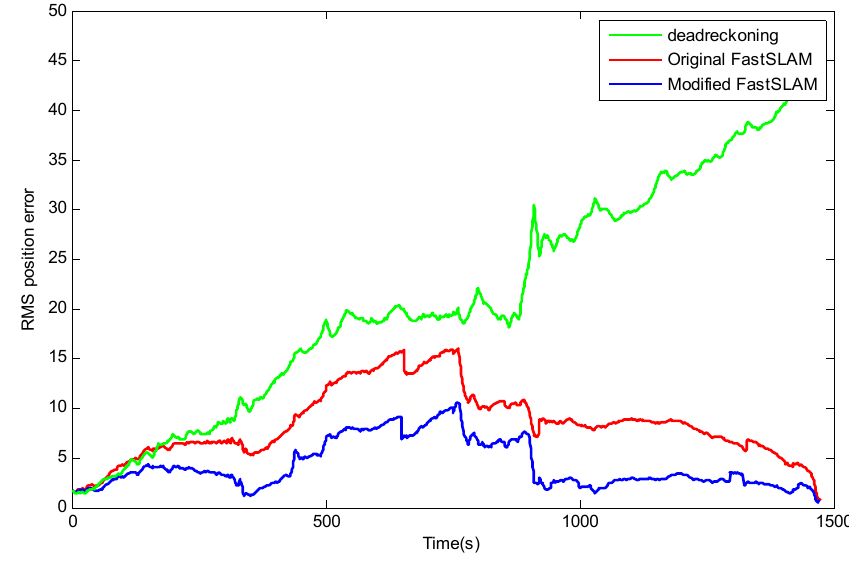
Figure 13. The position RMSE of Dead-Reckoning, original FastSLAM and modified-FastSLAM by averaging over 50 independent runs.